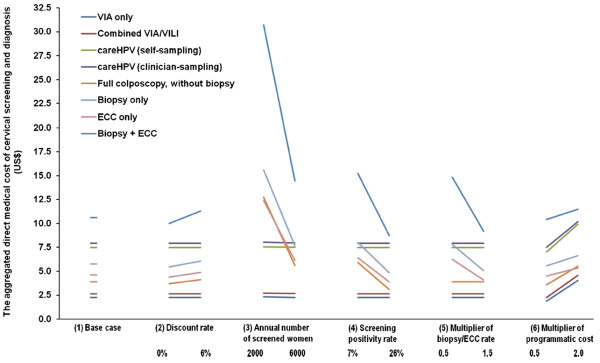
One-way sensitivity analysis (SA) for aggregated costs of screening and diagnosis†. † (1) Base case assumptions included: a discount rate of 3% [3,10], 11,475 women screened annually, a screening positivity rate of 14.6%, a cervical biopsy rate of 55% [27] and a ECC rate of 20% [28] for women with colposcopy. Various programmatic costs (including costs of advertising/ recruitment, training/quality control, and data management) ranged from $0.42 to $1.64. (2) SA for discount rate: 0%–6%; (3) SA for annual number of screened women: 2,000 and 6,000, based on previous experience, as explained in Methods. (4) SA for screening positivity rate: 7% [31] and 26% [32], two screening positivity rates observed in populations in China. (5) SA for multiplier of biopsy/ECC rate: because biopsy rate is usually clinician-dependent and subject to the underlying prevalence of disease in the population, we multiplied the rates at baseline for SA, as a function of multiplier of the biopsy/ECC rate at baseline (0.5, 1.5). (6) SA for multiplier of programmatic cost: the programmatic costs we used for baseline analysis were halved and doubled (0.5, 2.0), to account for the relatively large uncertainty associated with this parameter.